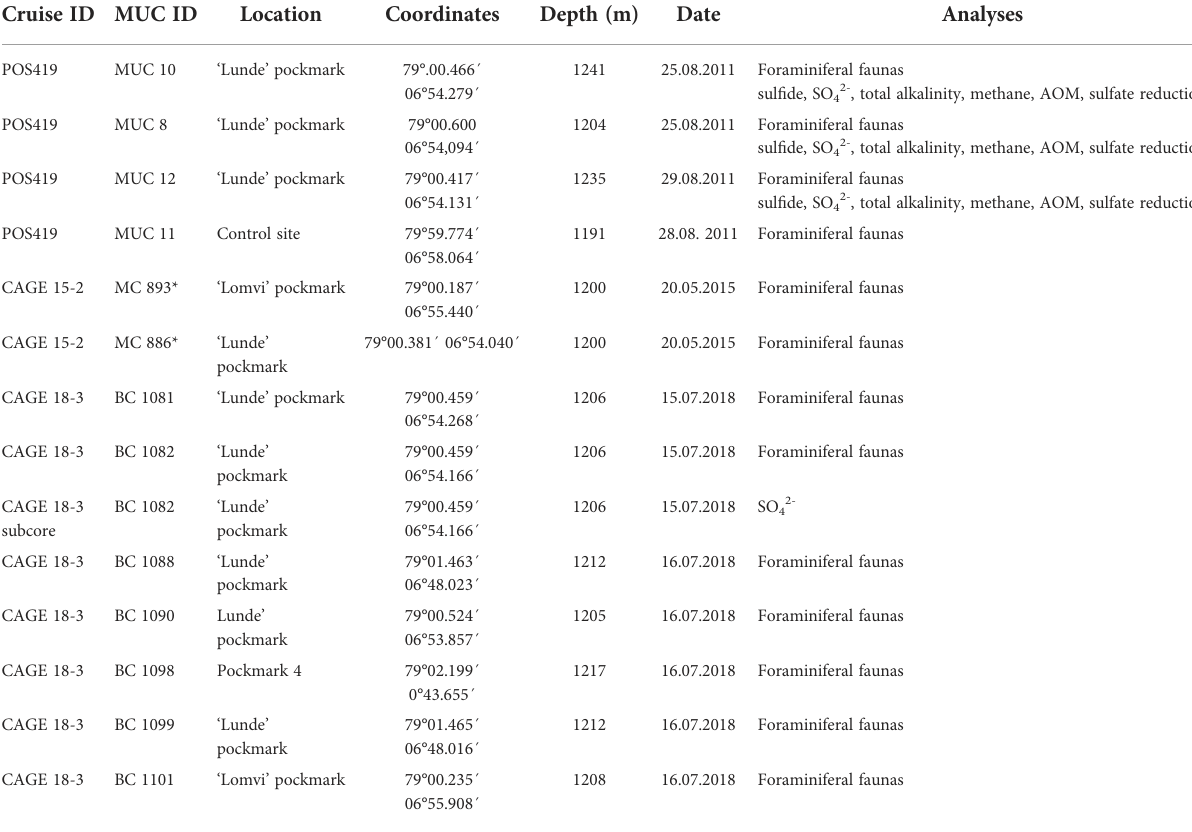
TABLE 1 Sampling locations, coordinates, water depth, date of sampling, environmental characteristics and analyses performed at sampling